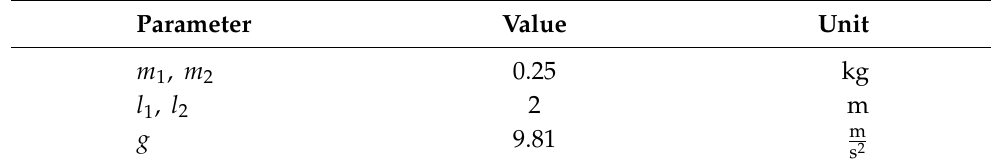
Table 3. Parameters of the robot.